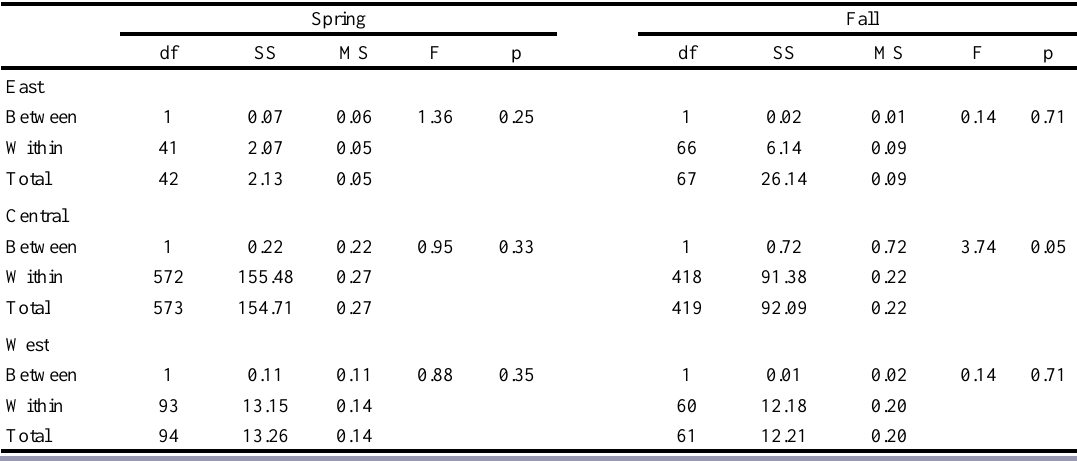
Table 4. Analysis of variance for circular data results comparing migration directions between short vs. long-distance migrant in spring and fall migration, respectively, based upon subsets of banding and recovery locations for 1261 passerines banded and recovered between 1914 and 2004.